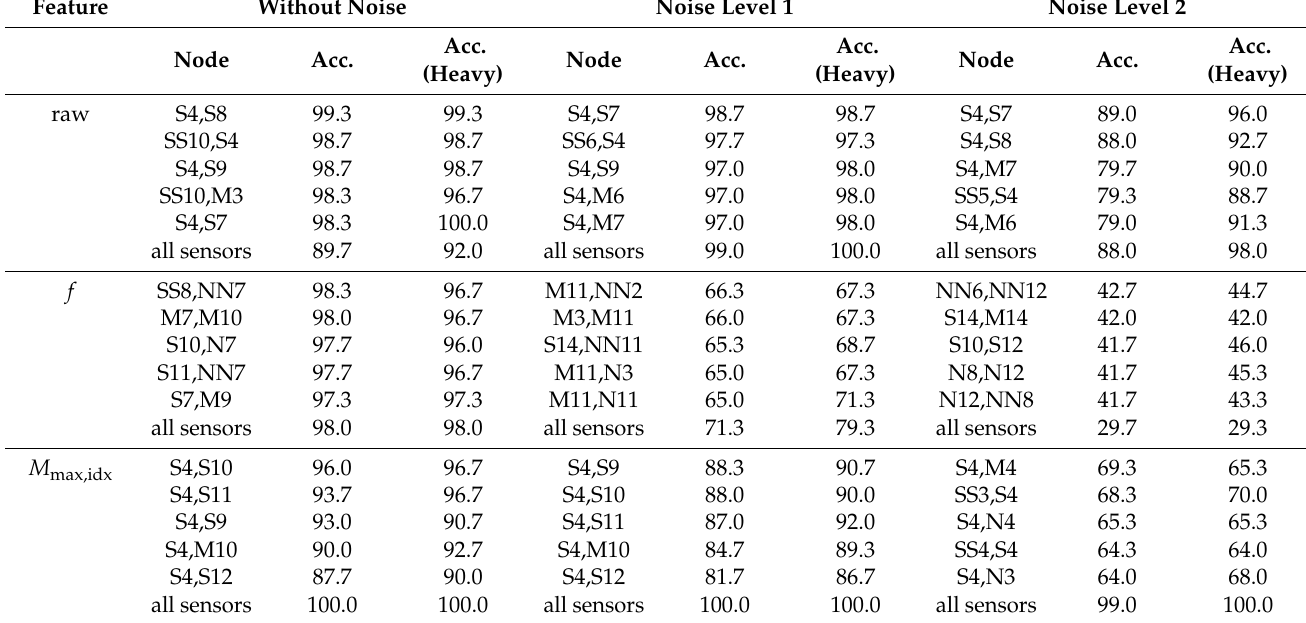
Table 3. Results for the five sensor pairs of each feature with the highest accuracy (Acc.) calculated based on strain in the x direction. The bottom six rows show the result for using all features. In the first column, the results for a Without Noise signal are given. The standard deviation of the noise σ N and the corresponding SNR for the noise levels can be taken from Table